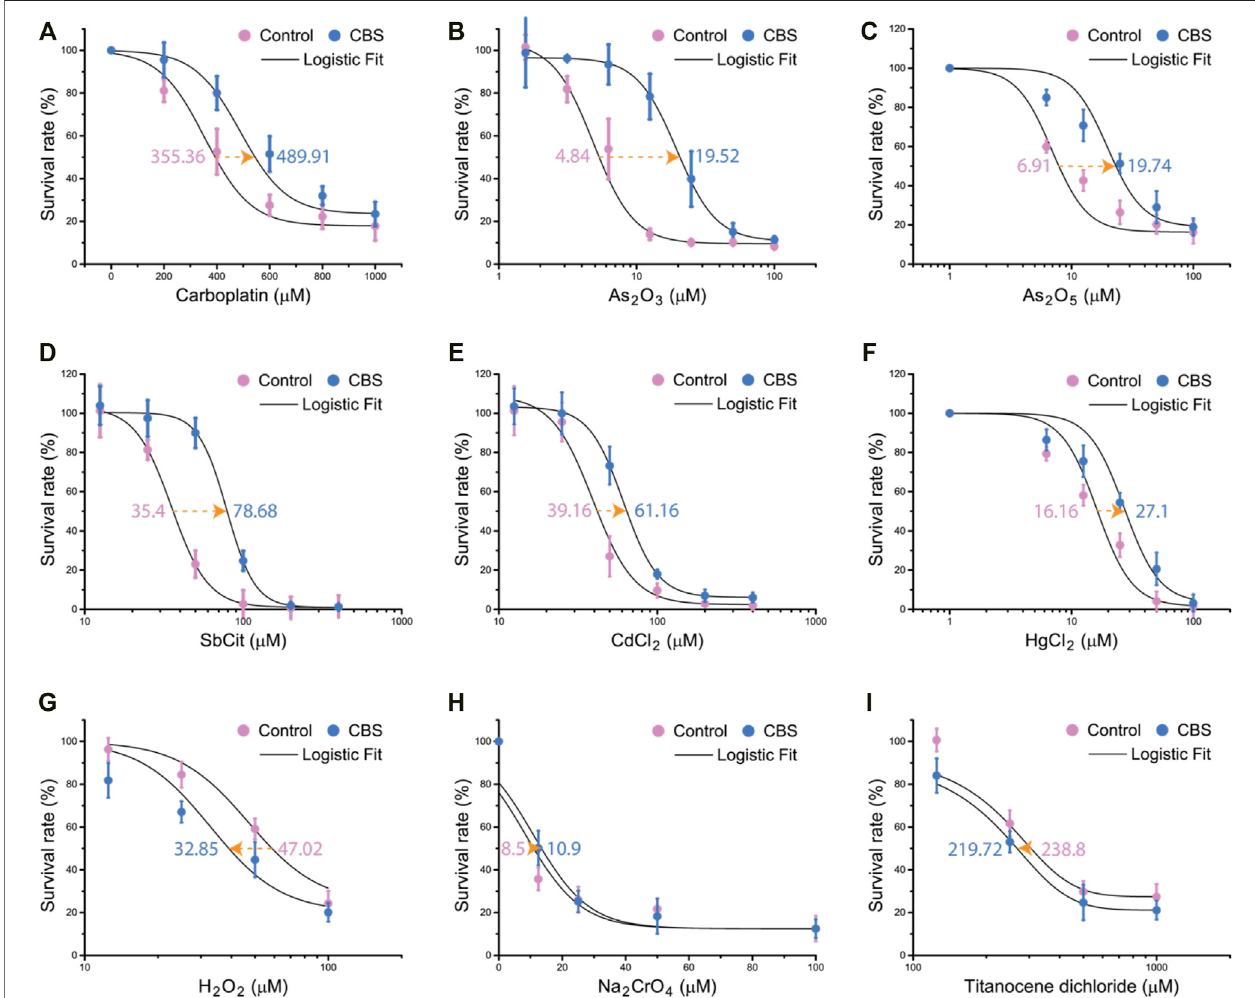
FIGURE6| Bismuthmitigatesthetoxicityofsoftmetalcompoundsbutnotoxidantsorhardmetalcompounds.CBSpretreatmentincreasestheLD50ofHK-2cells against soft metallodrugs and pollutants: (A) carboplatin, (B) arsenic trioxide (As 2 O 3 ), (C) arsenic pentoxide (As 2 O 5 ), (D) antimony citrate (SbCit), (E) cadmium chloride (CdCl 2 ), and (F) mercury chloride (HgCl 2 ). CBS pretreatment did not increase the LD50 of HK-2 against oxidants: (G) hydrogen peroxide (H 2 O 2 ) and (H) sodium